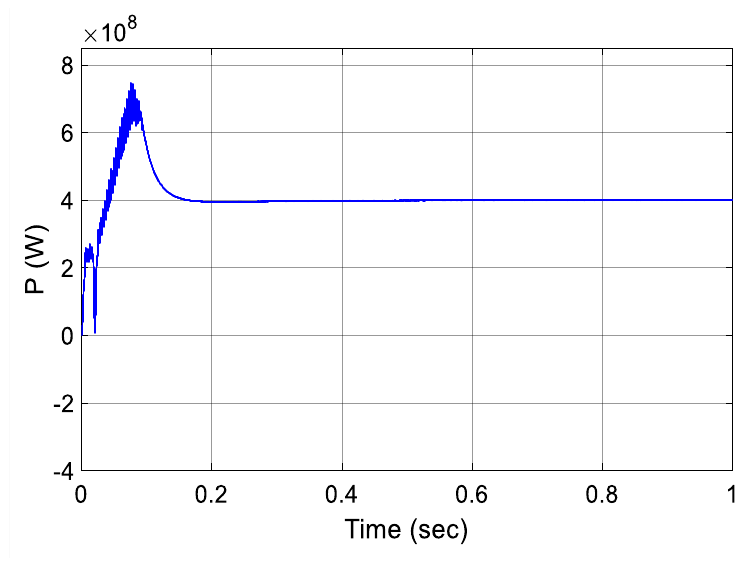
Figure 7. Active power transmission at terminal-II.